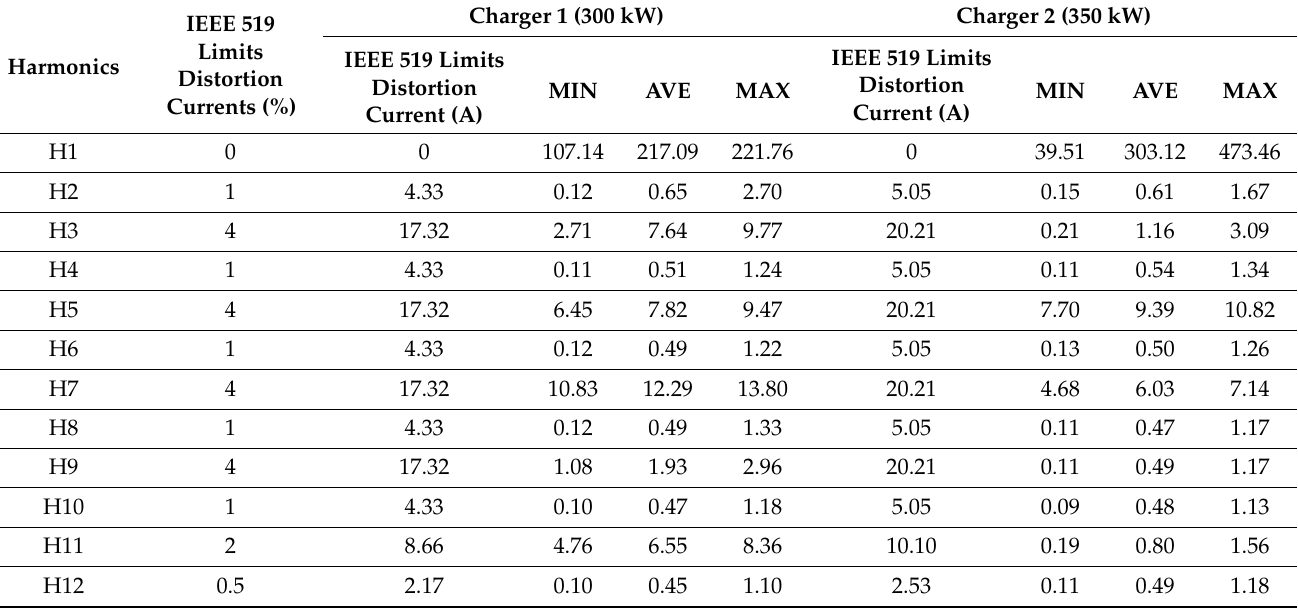
Table 3. Currents harmonics during a full bus